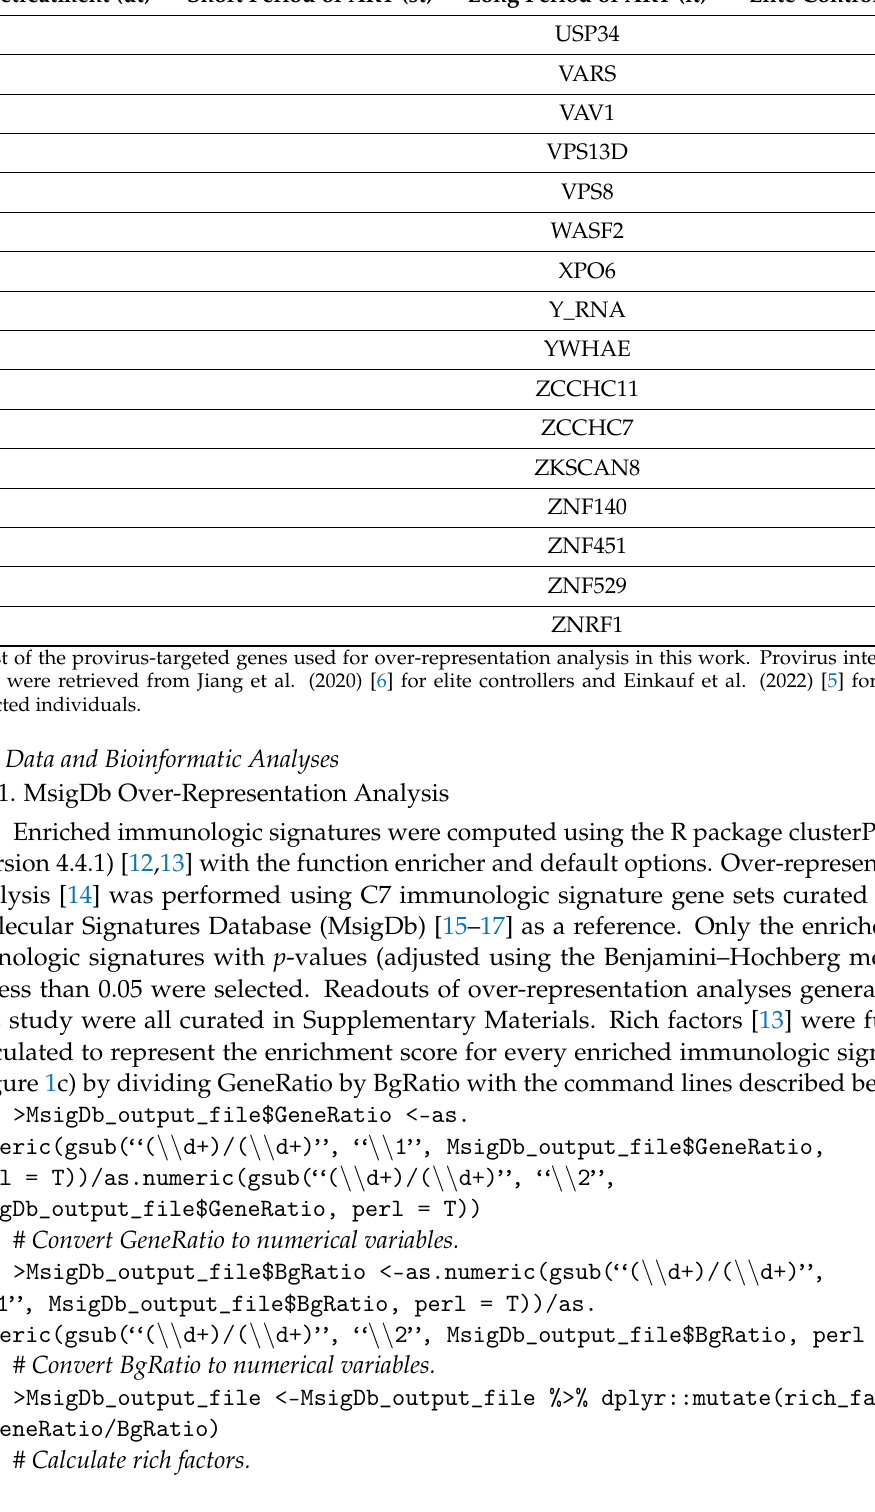
Table 1. Cont. Pretreatment